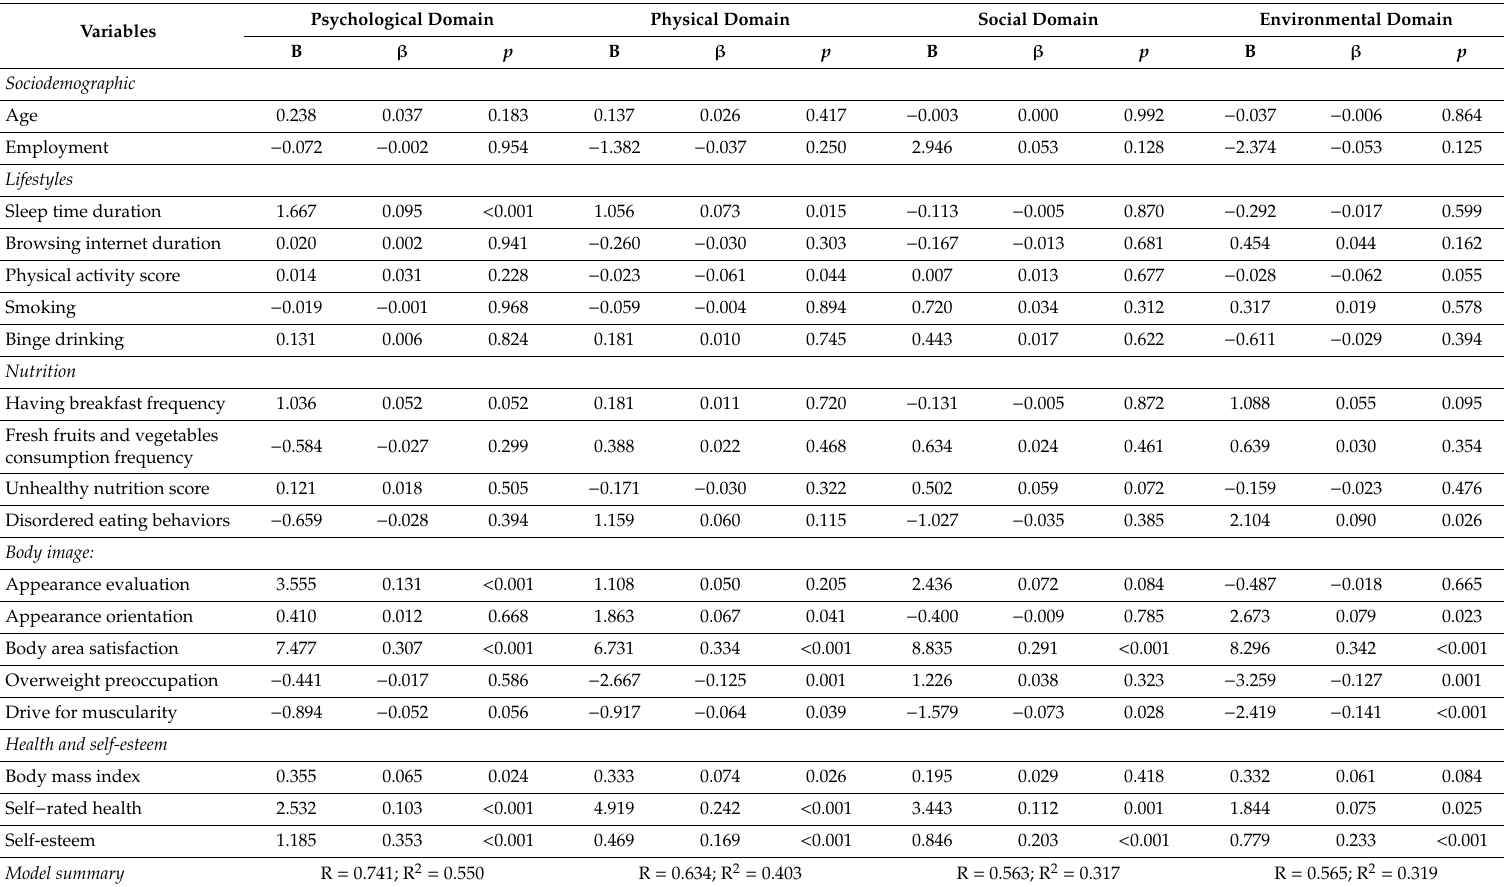
Table 3. Variables associated with di ff erent domains of the quality of life in male students ( n = 763).